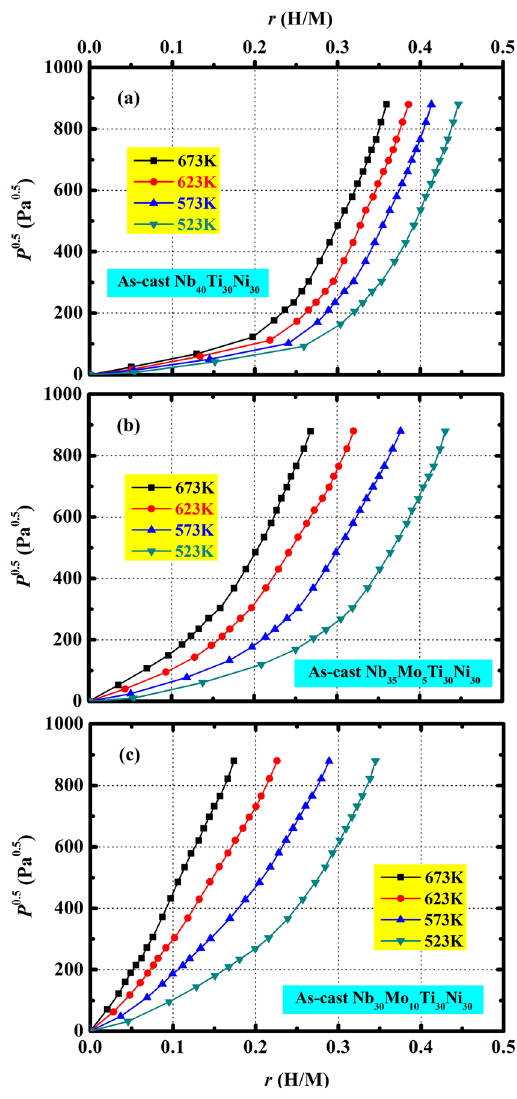
Figure 3. PCT curves for as-cast Nb 40 Ti 30 Ni 30 ( a ), Nb 35 Mo 5 Ti 30 Ni 30 ( b ) and Nb 30 Mo 10 Ti 30 Ni 30 ( c ), measured at 523 … 673